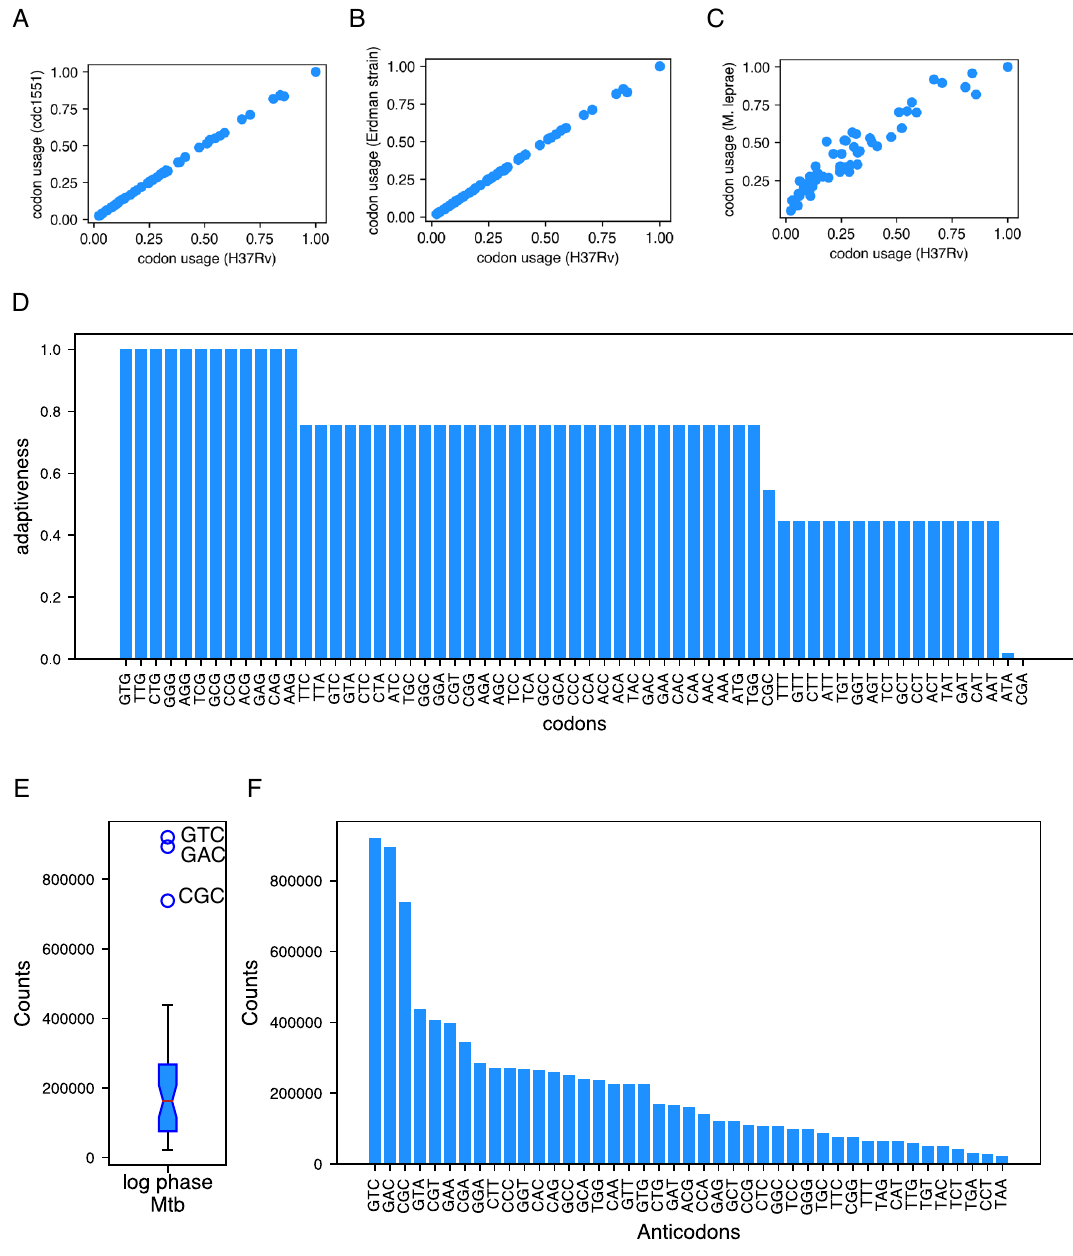
Figure 1. Mtb tRNA pool exhibit wide variability in the abundance of tRNAs. ( A–C ) Scatterplots showing genomic codon usage values of H37Rv and CDC1551 ( A ), H37Rv and Erdman strain ( B ), and H37Rv and M. leprae ( C ). ( D ) TAc values calculated using the gene copy numbers. ( E ) A box plot showing normalized read counts obtained from a tRNA-HySeq experiment done with log phase Mtb. ( F ) Normalized read counts for each anticodon depicted as a